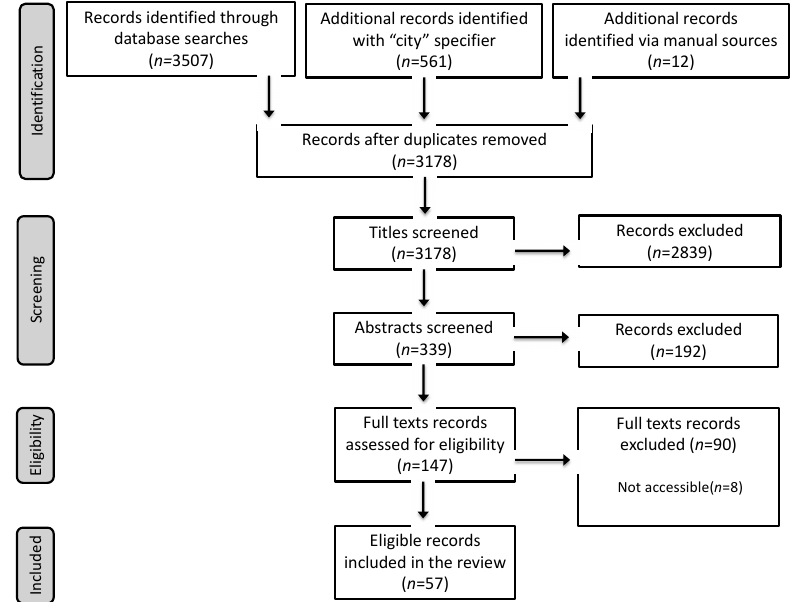
Figure 2. Study selection flowchart.